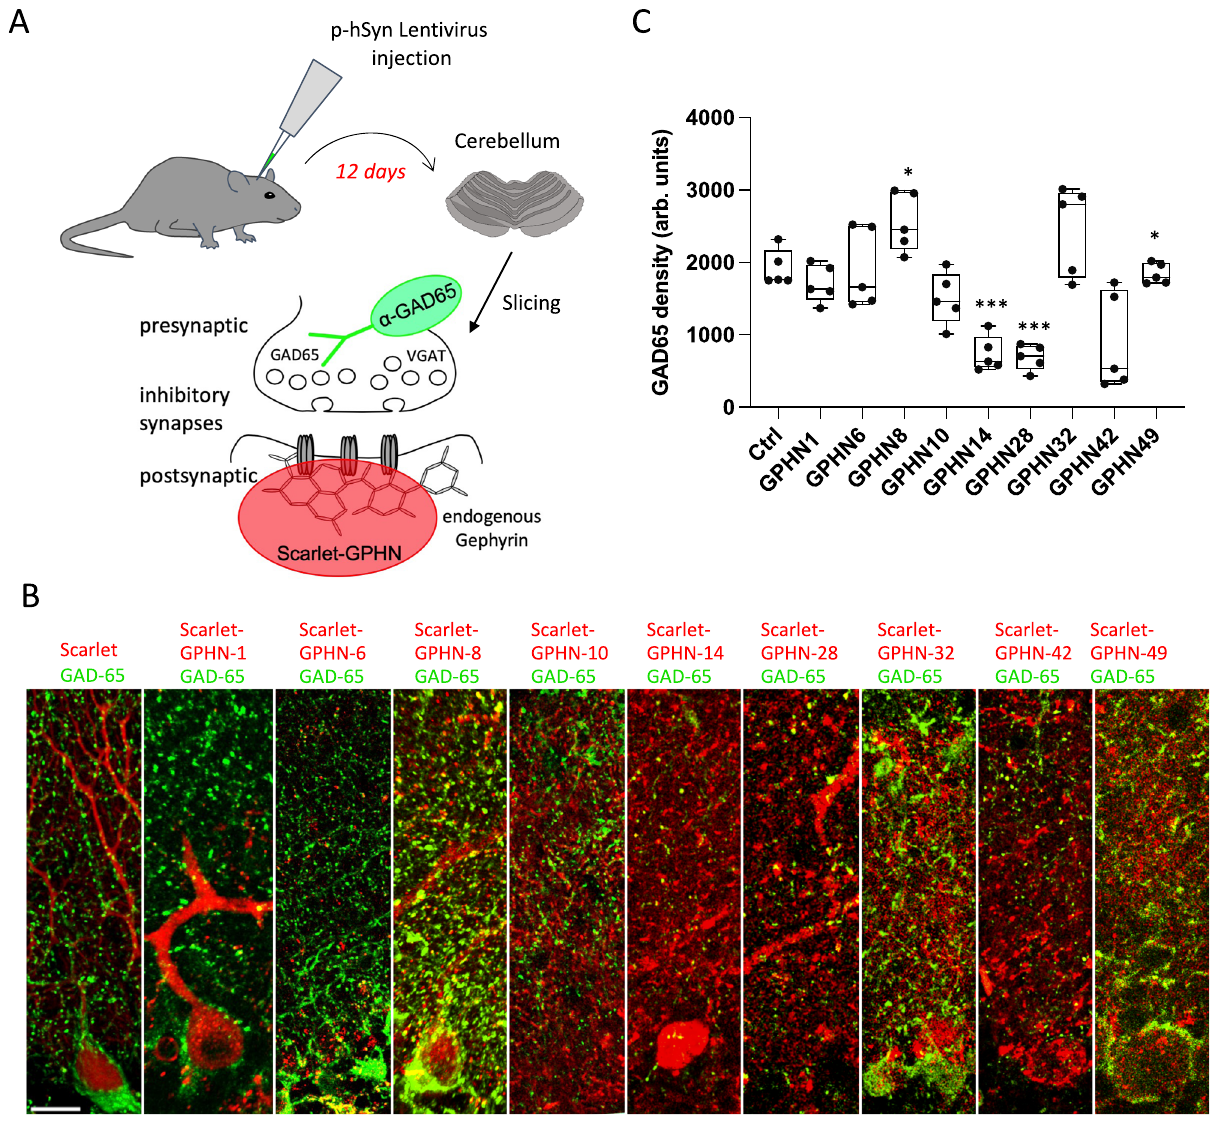
Fig. 5 Increase of GPHN isoform levels modulates the number of inhibitory synapses in mouse cerebellum. Analysis of inhibitory synapses connected to Purkinje cells in mouse cerebellar slices after transduction of lentivirus expressing Scarlet-tagged GPHN isoforms. A Schematic displaying the experimental procedure. B Cerebellar cortex slices in which inhibitory synapses are stained at pre- and postsynaptic sides using anti-GAD65 antibody (green) and Scarlet fl uorescence (red), respectively ( n = 5 mice for each isoform). C Quanti fi cation of GAD-65 density detected in panel B ( n = 5 independent experiments). Box boundaries in C are the 25th and 75th percentiles, the horizontal line across the box is the median, and the whiskers indicate the minimum and maximum values. ***P < 0,0010, *P = 0,0179 and *P = 0,0128 for GPHN8 and GPHN49, respectively. Two-sided Student's t -test. Scale